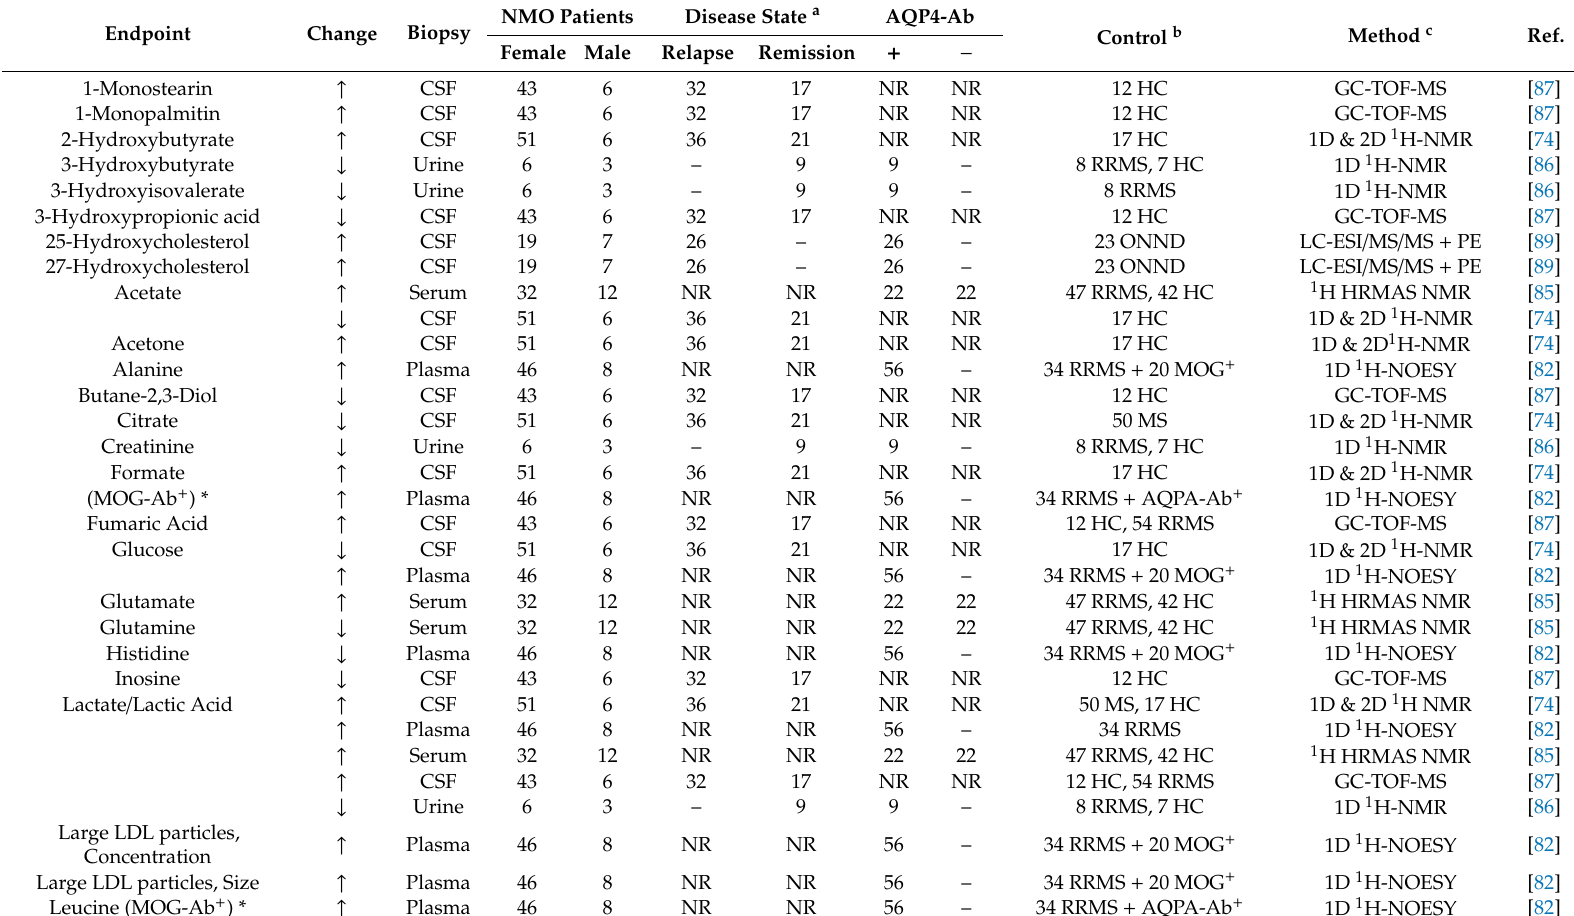
Table 1. Altered Metabolite Outcomes in Neuromyelitis Optica Spectrum Disorder (NMOSD) Metabolomic